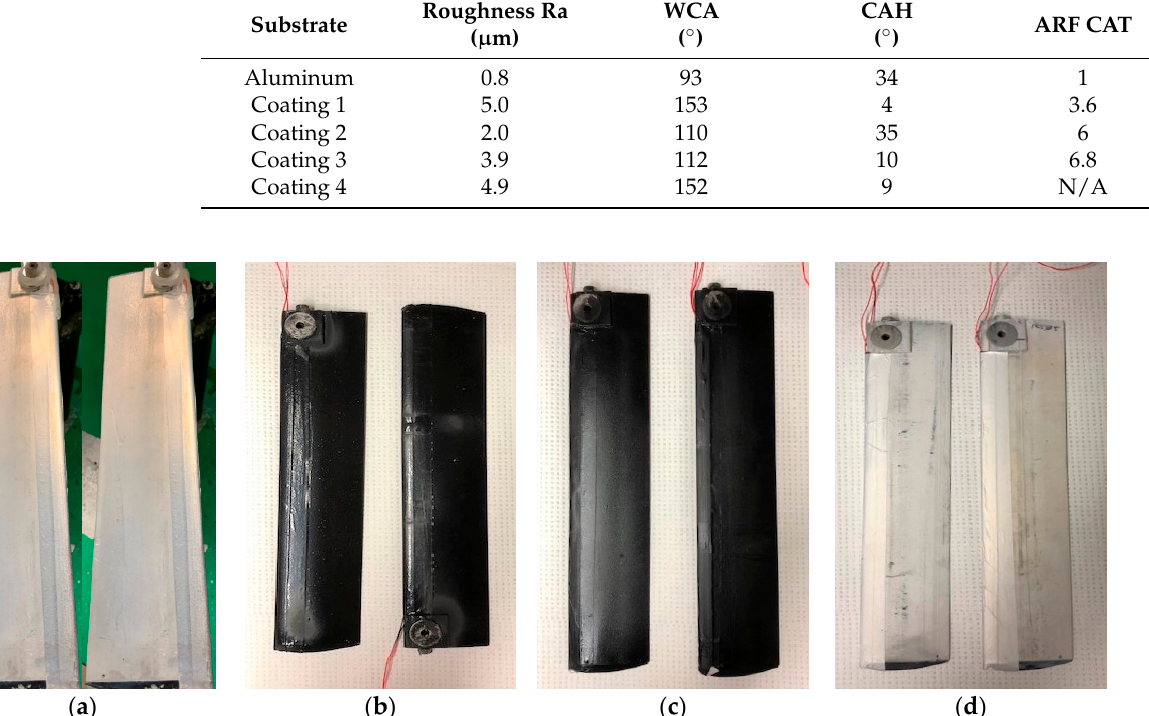
Figure 8. Blades covered with ( a ) Coating 1; ( b ) Coating 2; ( c ) Coating 3; and ( d ) Coating 4.